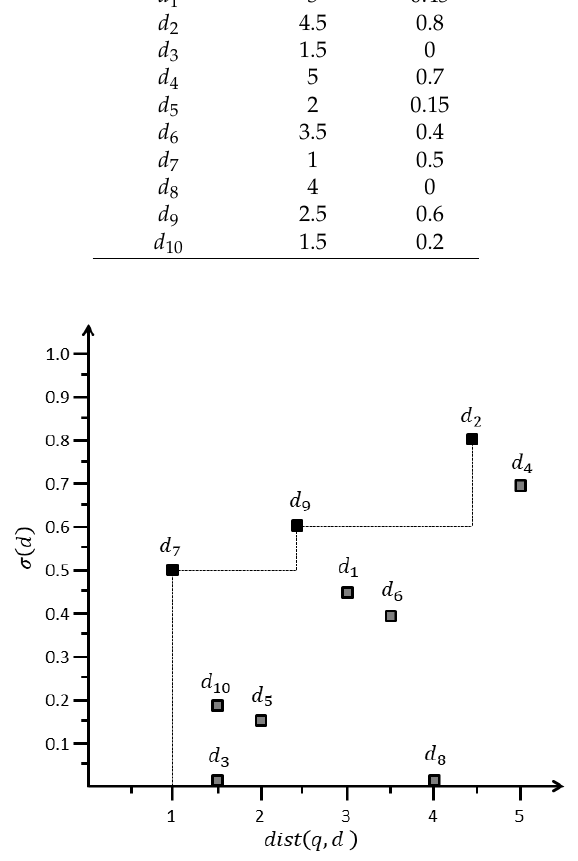
Figure 6. Distance-score